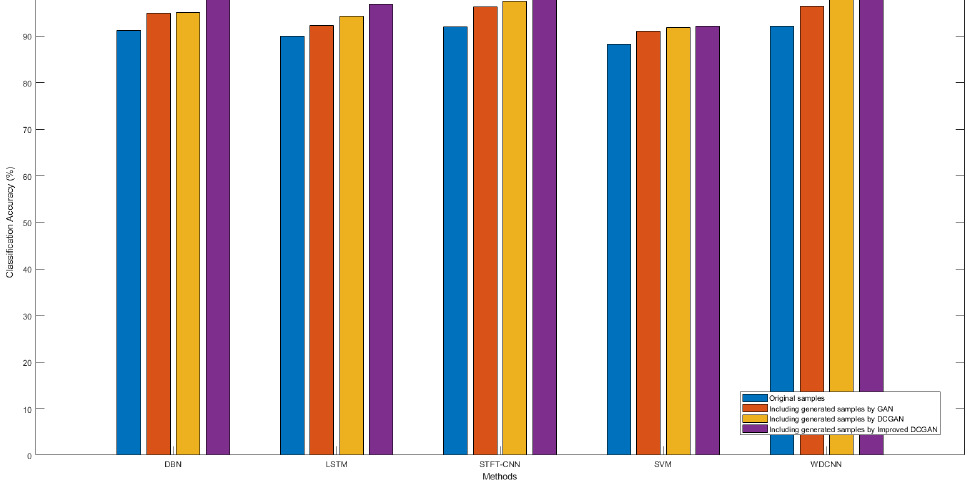
Figure 18. Comparisons of classification results. Appl. Sci. 2022 , 12 , x FOR PEER REVIEW